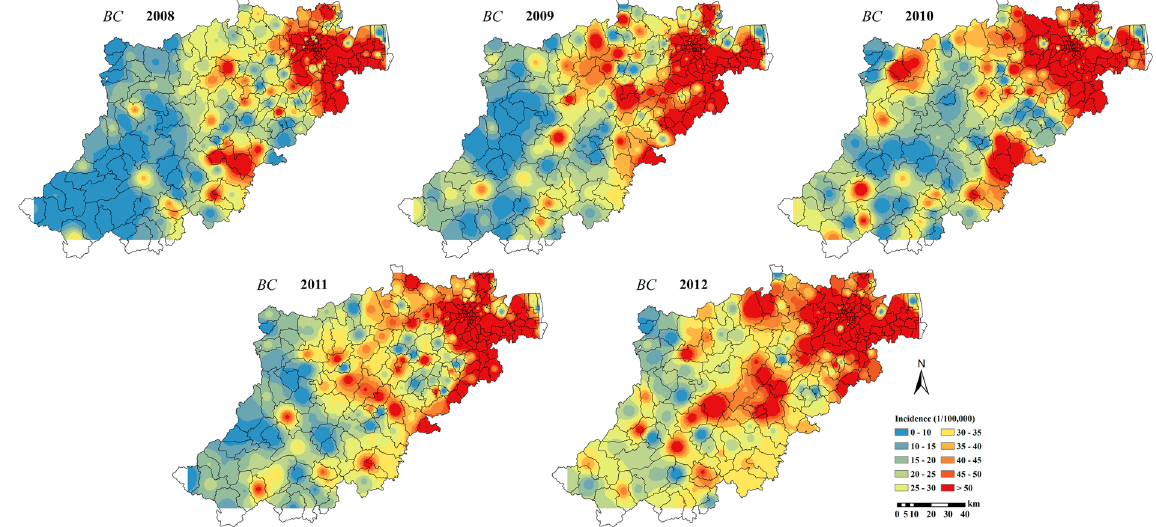
Figure 9. The original distribution of BC incidence. Maps were generated using ArcGIS 9.3. URL link: http:// desktop.arcgis.com/zh-cn/desktop/.